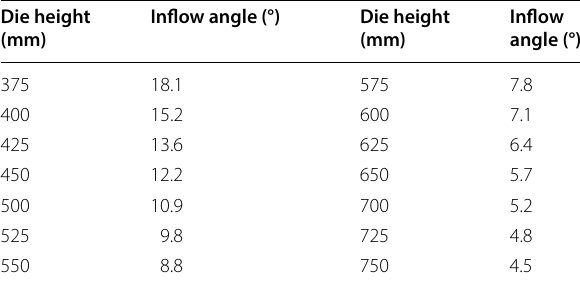
blank change according to shape factor ( a ) as shown in Figure 10. To minimize forming load, design of the shape of tractrix die was implemented by varying die heights (375 ‒ 750 mm) at the interval of asymptote (25 mm). Inflow angles of material according to die height are listed in Table 3, and dd 1 (536.94 mm) is fixed value in the basis of Table 2 [23–25].